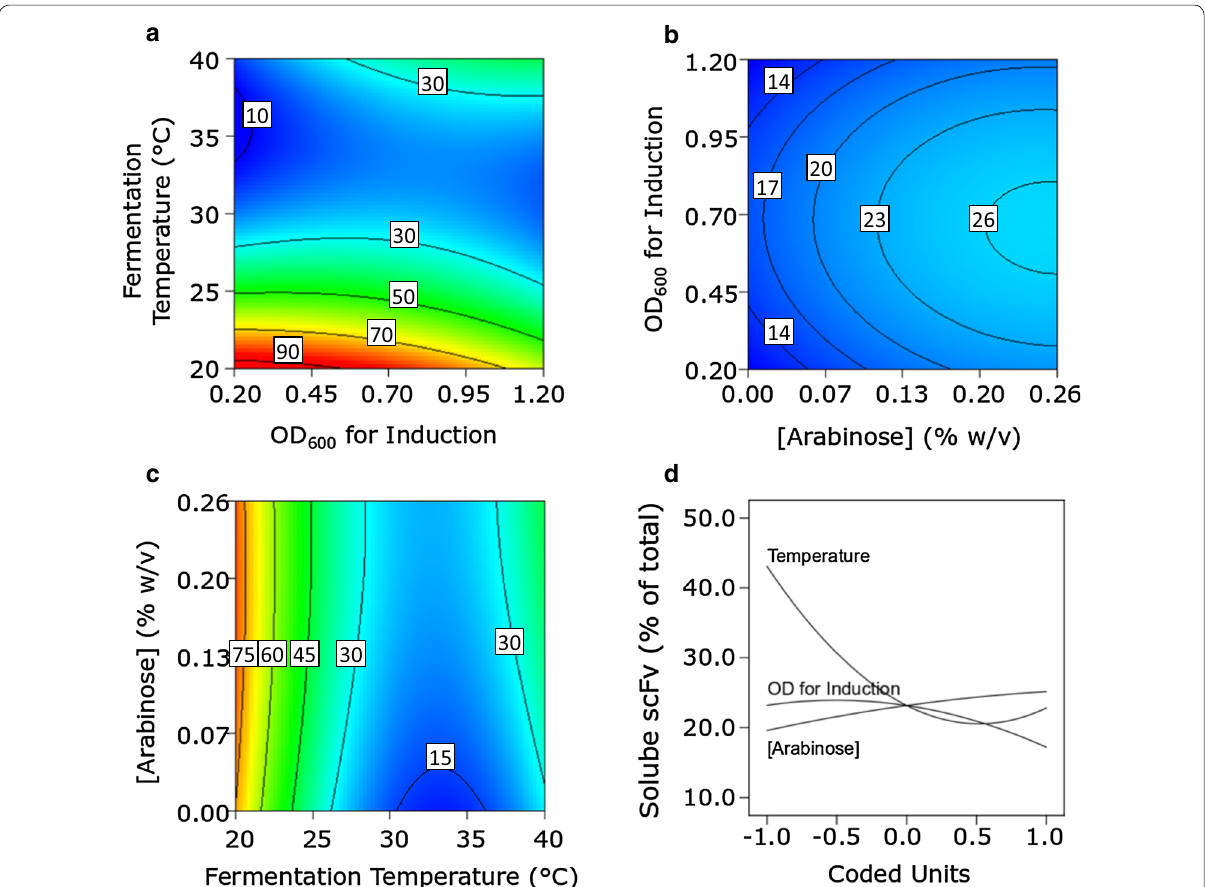
Fig. 3 Response ( a – c ) and perturbation ( d ) plots for the percentage solubility of DsbA sp -scFv. Response plots show the response of two factors; the third invariant factor is set at level ‘0’. Units in response plots are µg scFv mL − 1 culture h −